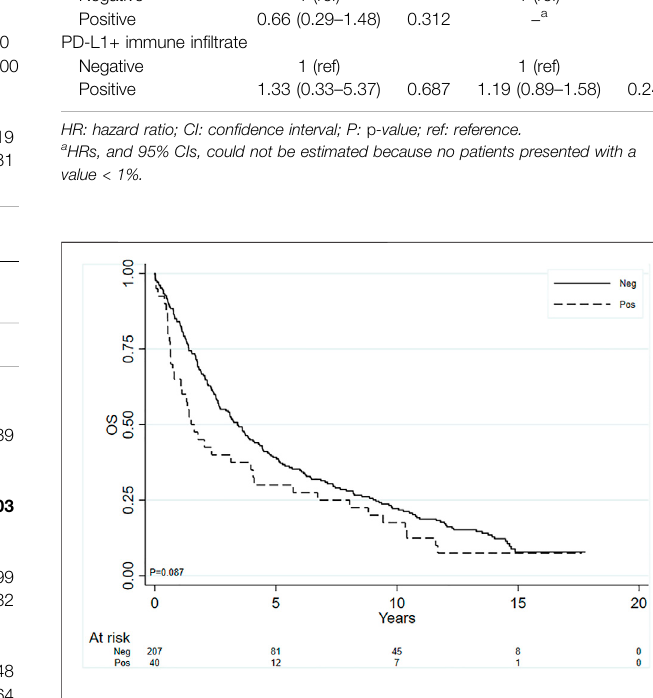
FIGURE 2 | Kaplan-Meier curves for OS, comparing the subgroup of patients with both PD-L1 and vimentin positive in tumor cells (cutoff value ≥ 1% for both the biomarkers) with all the